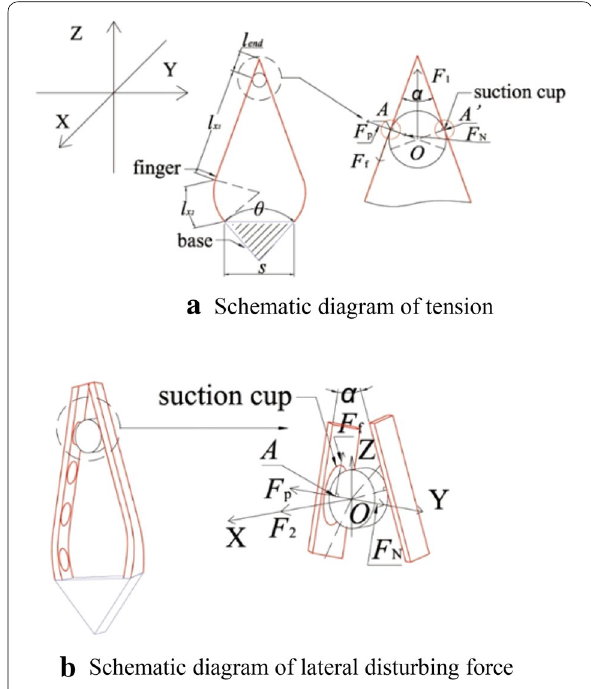
Figure 7 Grasping schematic diagram of SOHE